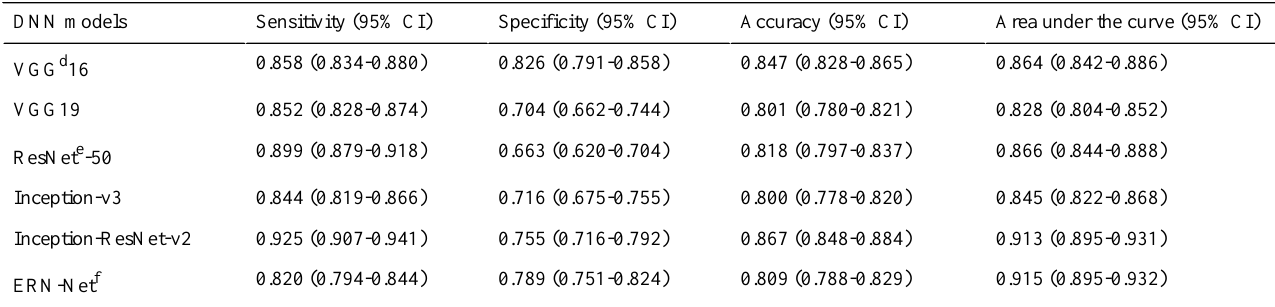
Table 4. Performance of different deep neural network (DNN) models on the T1 a -T2 b -T1c c -fused images for image-based